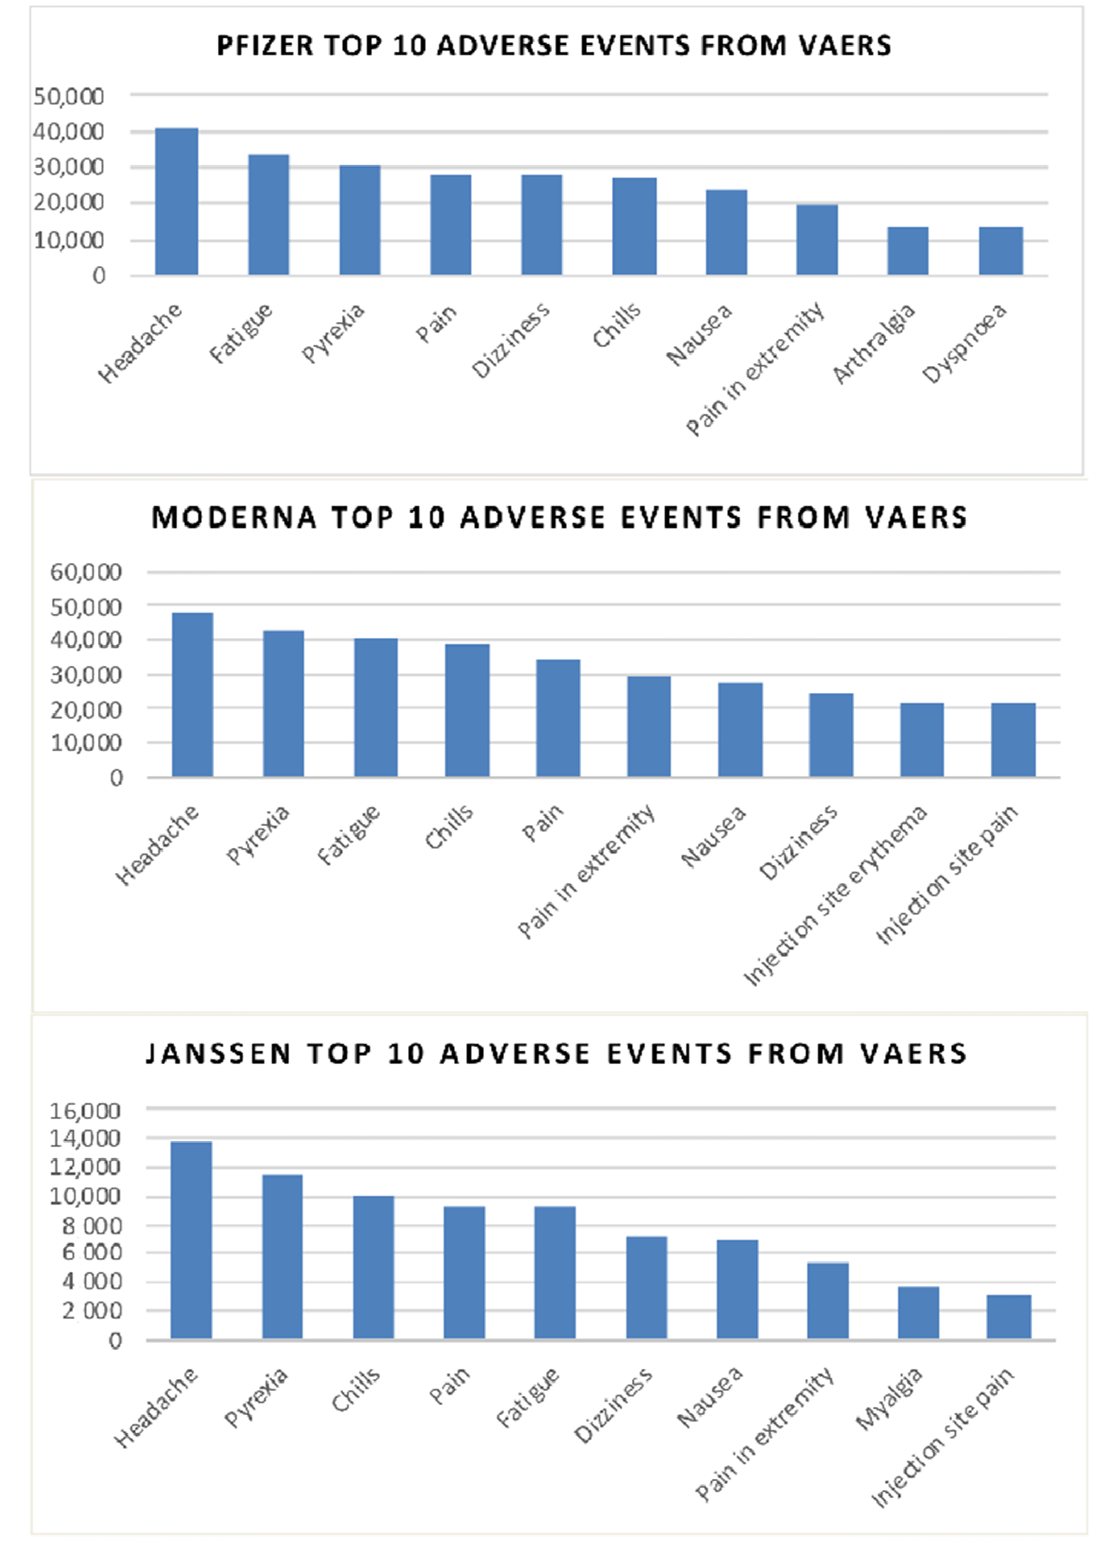
mentioned VAEs in